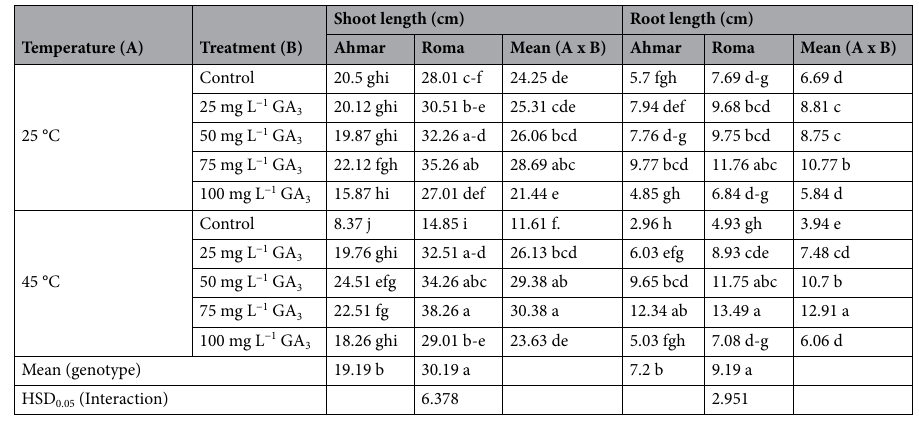
Table 1. The length of the tomato shoots and roots, as impacted by temperature, genotype, and exogenous application of GA 3 . According to Tukey’s honestly significant difference test, the same letters suggest that there is no statistically significant difference between treatments ( p ≤